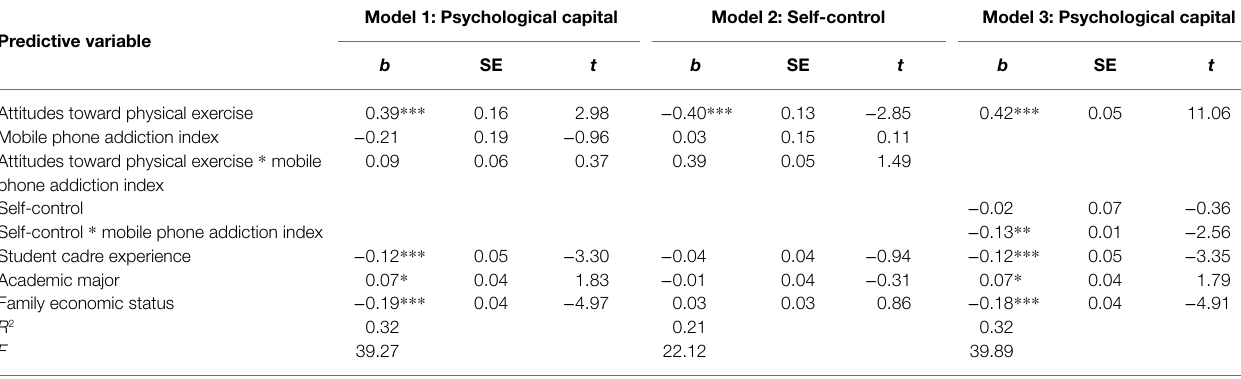
TABLE 3 | Predictive ability of the study variables based on non-parametric percentile bootstrapping.